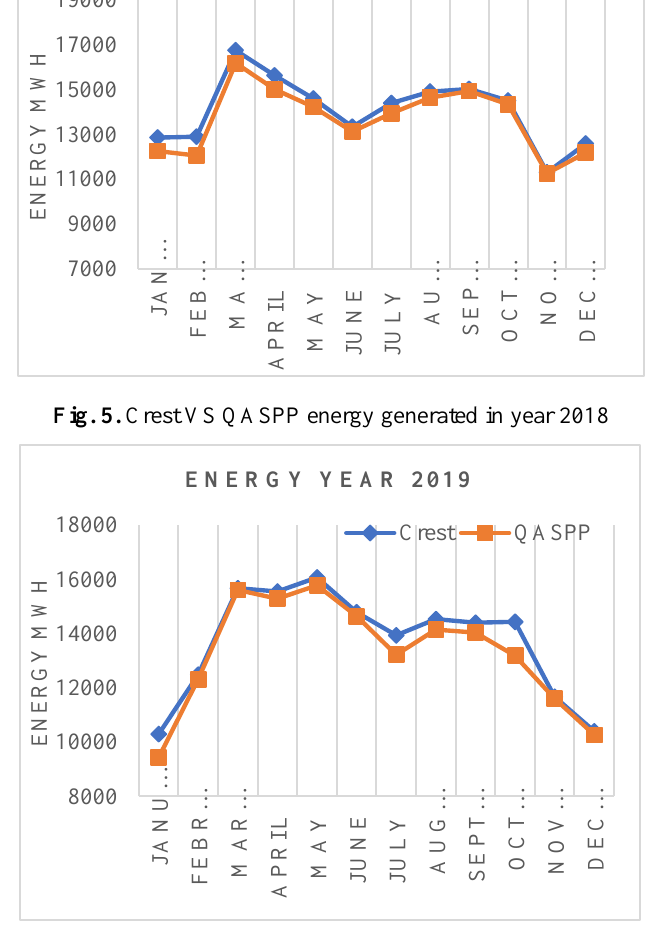
Fig. 6. Crest VS QASPP energy generated in year 2019